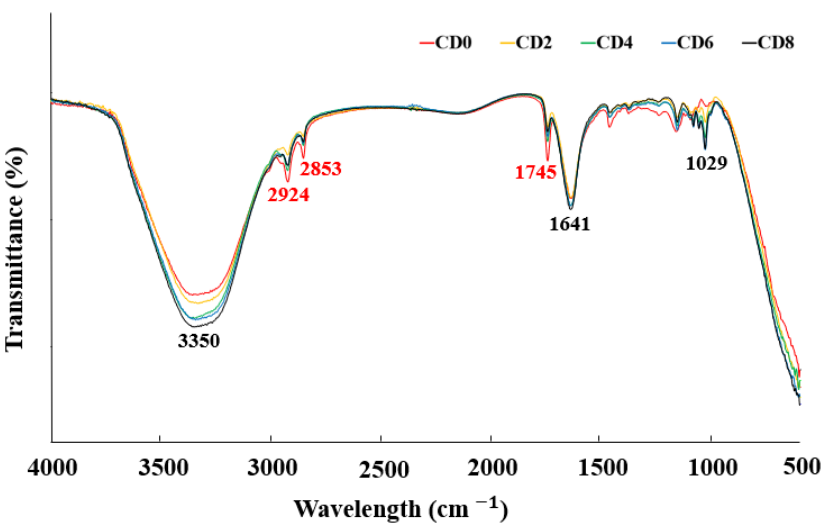
Figure 1. Fourier-transform infrared (FT-IR) spectra of the emulsion gels. The konjac (4%, w / w ) emulsion gels were supplemented with various concentrations of cyclodextrin (CD; 0 – 8%, w / w ). The peaks detected at wavelengths 3350 and 1641 cm −1 indicate O-H stretching, while those detected at 2924 and 2853 cm −1 indicate -CH 2 - stretching in long-chain fatty acids. The peaks detected at wavelengths of 1745 and 1029 cm −1 indicate C=O stretching in fatty acid esters and C-O stretching vibration in anhydro-glucose units, respectively ( n = 3). Red, CD0 (0% CD-supplemented konjac- based emulsion gel); yellow, CD2 (2% CD-supplemented konjac-based emulsion gel); green, CD4 (4% CD-supplemented konjac-based emulsion gel); blue, CD6 (6% CD-supplemented konjac-based emulsion gel); black, CD8 (8% CD-supplemented konjac-based emulsion gel).